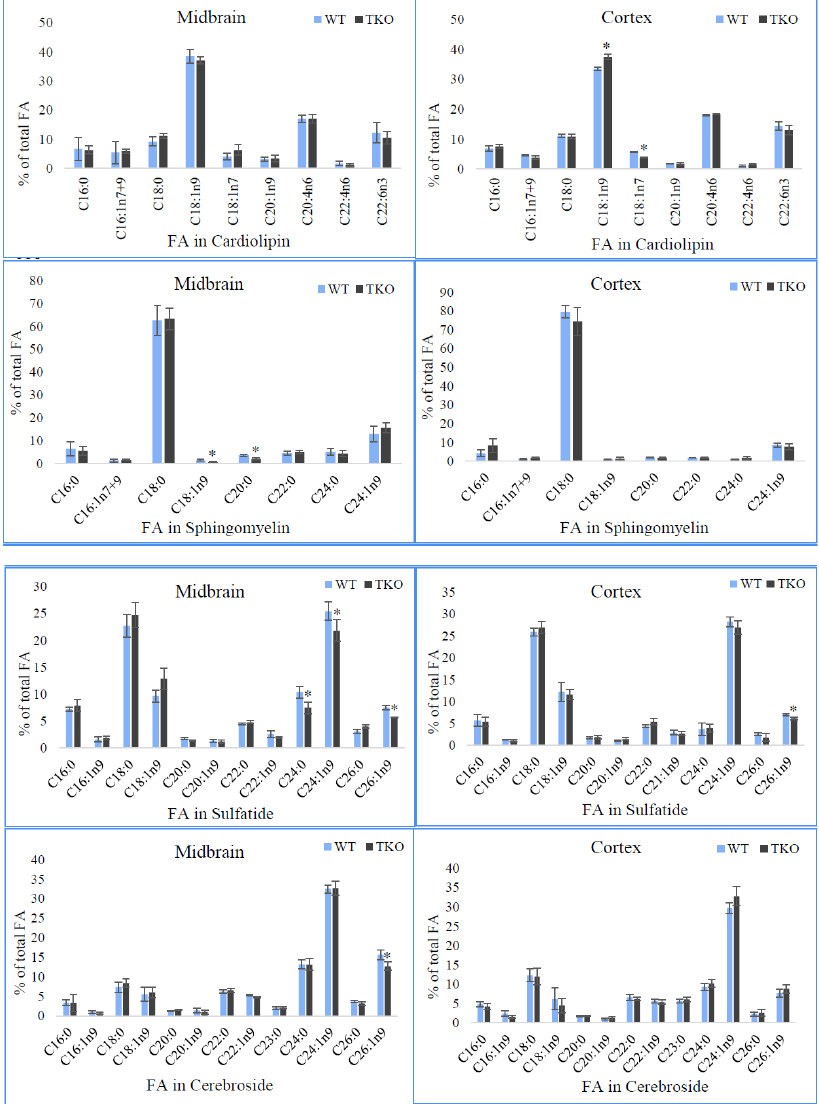
Figure 6. Fatty acid and dimethylacetal (DMA) composition in the individual polar lipid classes (% of total PL fatty acids) from the midbrain and cortex of wild-type (WT) and triple-synuclein null mutant (TKO) mice. For sulfatides and cerebrosides, the conventional (non-hydroxylated) fatty acids are present. Means ± s.d. ( n = 6) are shown. Fatty acids are indicated with the number before the colon showing the number of carbon atoms, the figure afterwards denoting the number of double bonds. The position of the first double bond is shown after “n”. Only the major fatty acids ( ≥ 0.5%) are present. The asterisk (*) indicates a significant effect of triple-synuclein deficiency when compared with WT ( p <